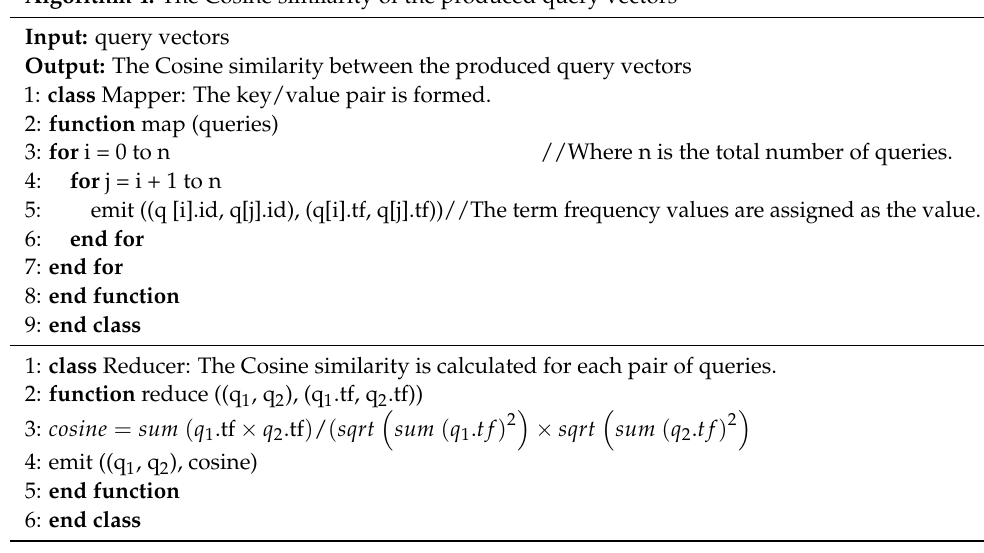
Algorithm 4: The Cosine similarity of the produced query